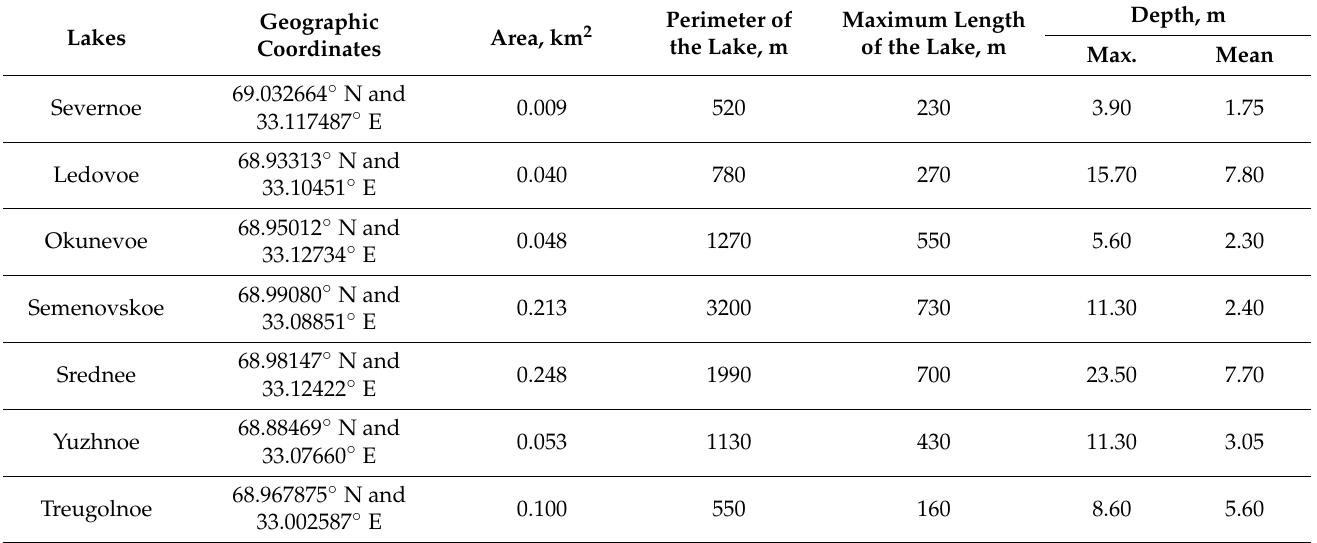
Perimeter of Maximum Length Area, km 2 the Lake, m of the Lake, m